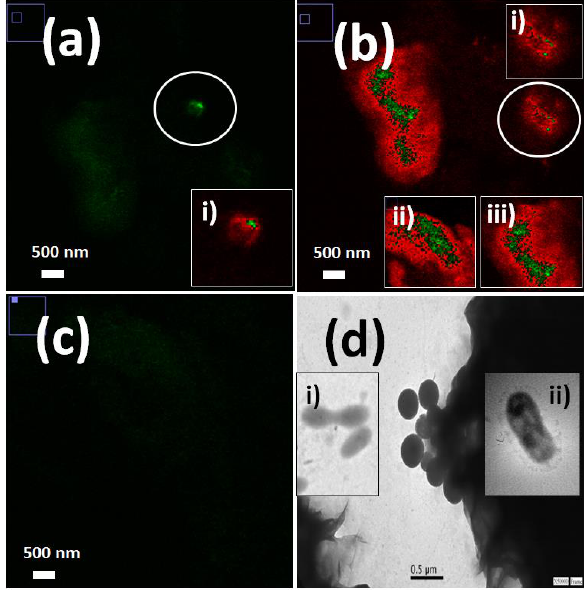
Figure 12. Laser fluorescence microscopy of labeled Cyanobacteria with: ( a ) mono-colored SiO2-RhB nanoparticles. Laser excitation at 543.0 nm. Inset image (i): single free SiO2-RhB nanoparticles; ( b ) mono-colored SiO2-Fl nanoparticles. Laser excitation at 488.0 nm; ( c ) multi-colored SiO2-RhB-Fl nanoparticles. Laser excitation at 488.0 nm; ( d ) TEM images of labeled Cyanobacteria with silica nanoparticles of 390.0 nm. Inset image (i) non-labeled Cyanobacteria aggregates; (ii) single-labeled Cyanobacteria. Reprinted with permission from ref. [94]. Copyright 2020, RSC.